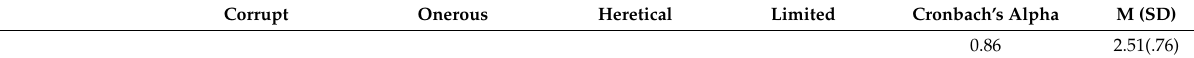
Table 2. EFA (Sample 1) and CFA (Sample 2) results, with reliability and descriptive